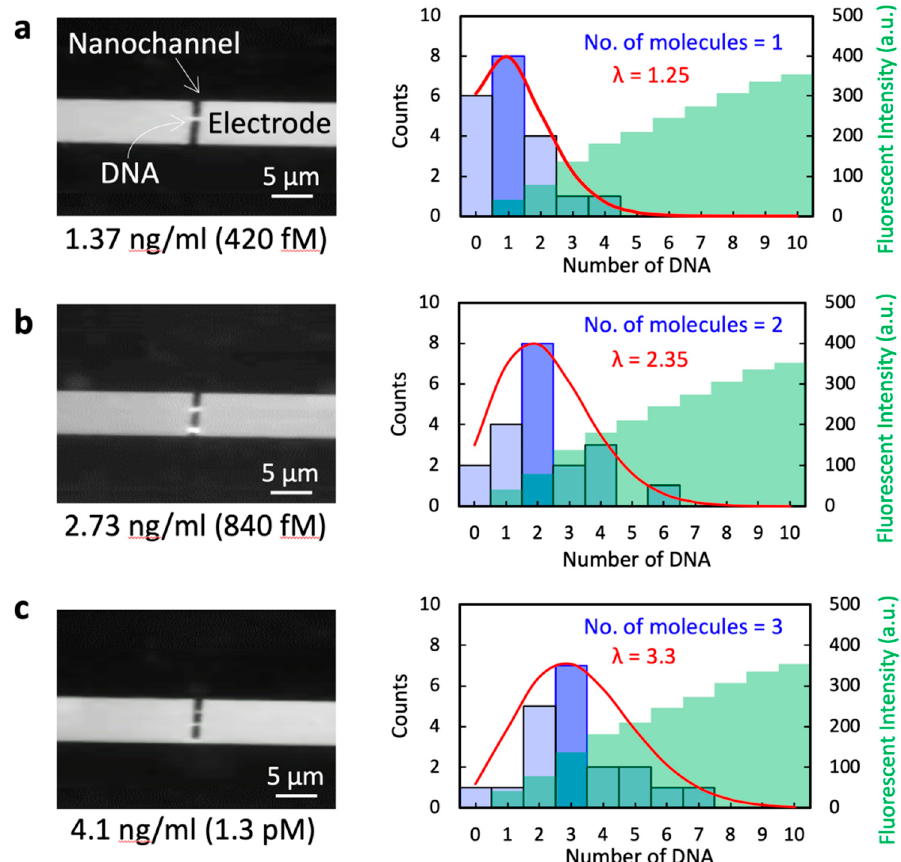
Figure 6. Fluorescent images of DNA in the electrode gap. These images were obtained with 5 kbp DNA in an 800 nm electrode gap at 0.5 MV/m field strength during electrical impedance measurements. The left-hand column presents fluorescence images of ( a ) single, ( b ) double, and ( c ) triple DNA molecules. The right-hand column shows the distribution histogram obtained from 20 replicate visualizations fitted to a Poisson distribution. Here, λ is the expected value of the Poisson distribution parameter. The green plots represent the corresponding histogram of the measured fluorescent intensity of each length of DNA.